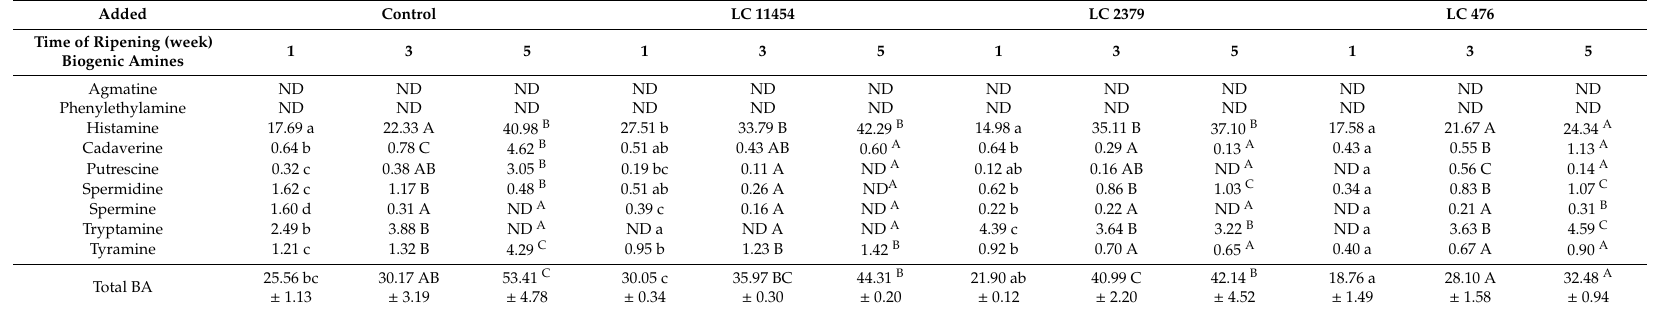
Table 5. Concentrations of biogenic amines (BAs) in Dutch-type cheese models during ripening (mg · kg − 1 ). Added Time of Ripening (week) Biogenic Amines